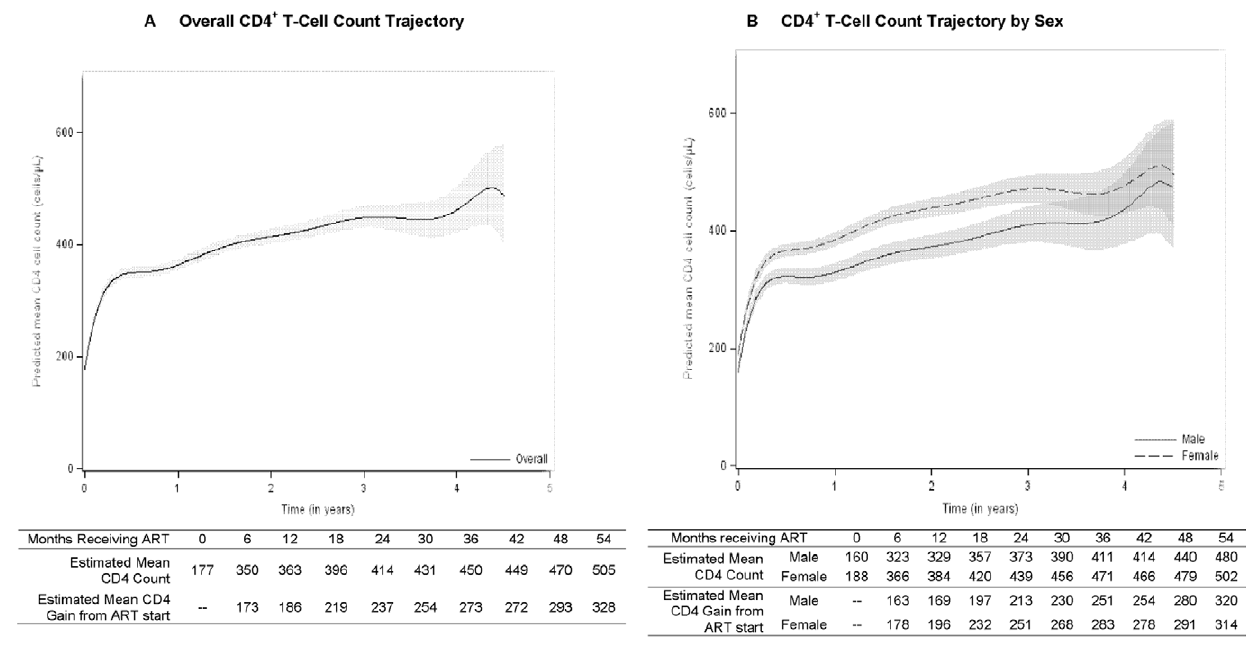
Figure 2. Modeled changes in CD4 count for surviving patients initiating antiretroviral therapy during 2004–2007.